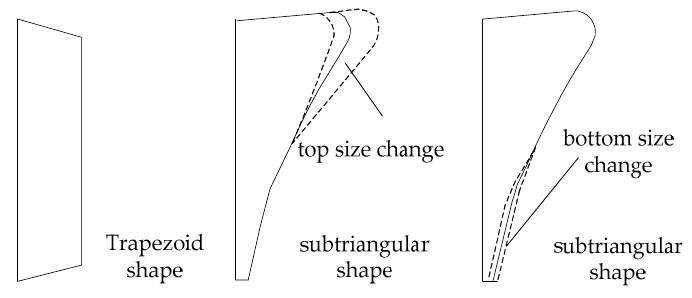
Figure 14. The shape of the non-magnetic conductor. The influence of the NMC shape on EF is shown in Figure 15.